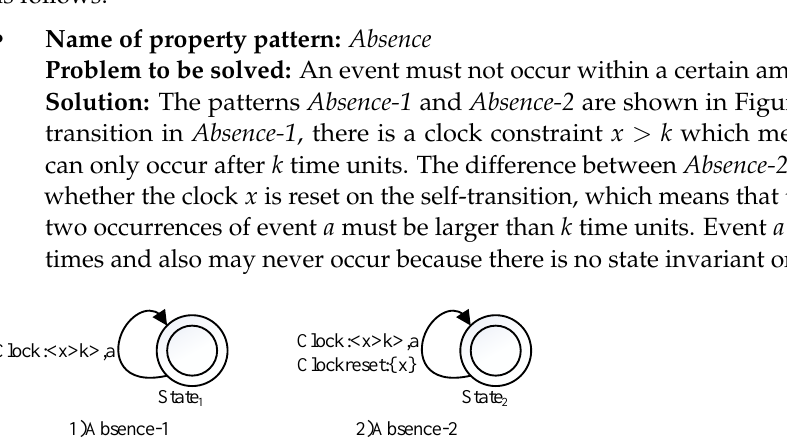
Figure 2. Property pattern of Absence.